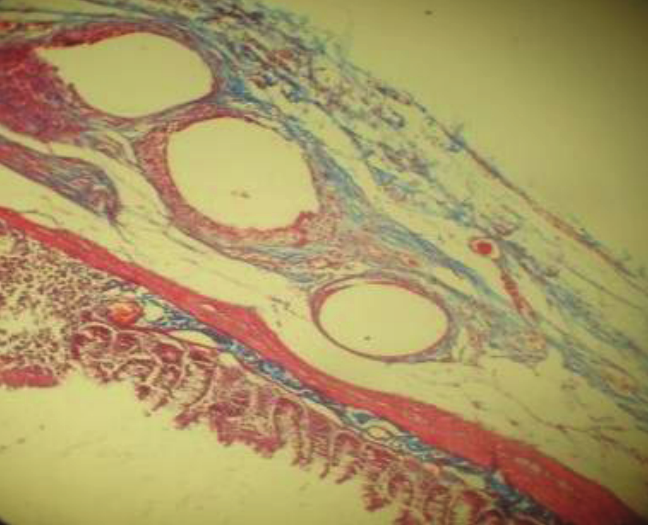
FIGURE 4 - Granulomatous reaction in Group 2, comprising the fibers of the mesh ( A ), associated with moderate fibrosis ( B ) and adherence to the intestinal wall ( C ). Tricromium of Masson 160x.